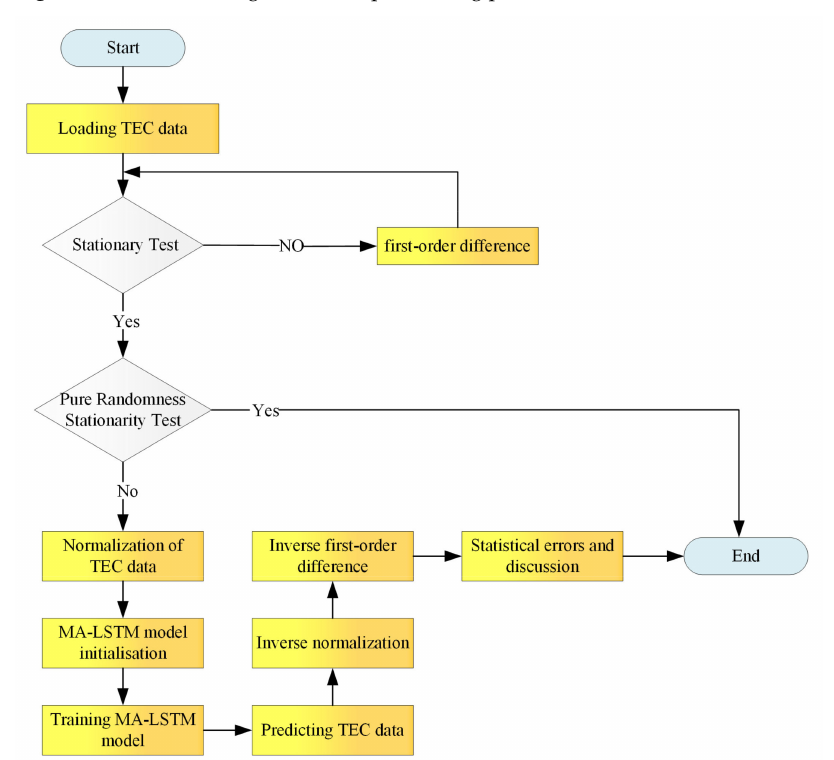
Figure 5. The entire experimental